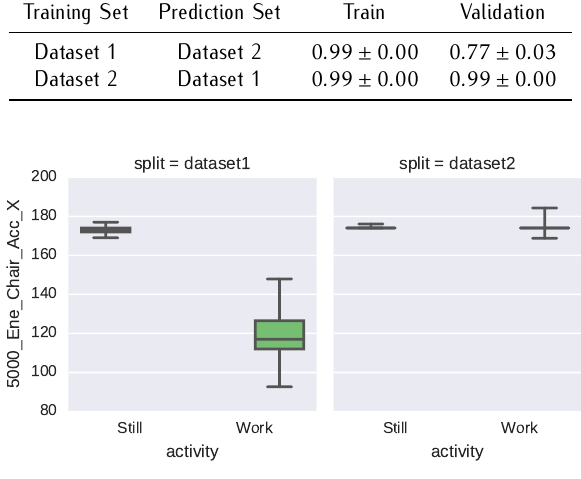
Figure 5. Example of a feature leading to a wrong classification second one to the